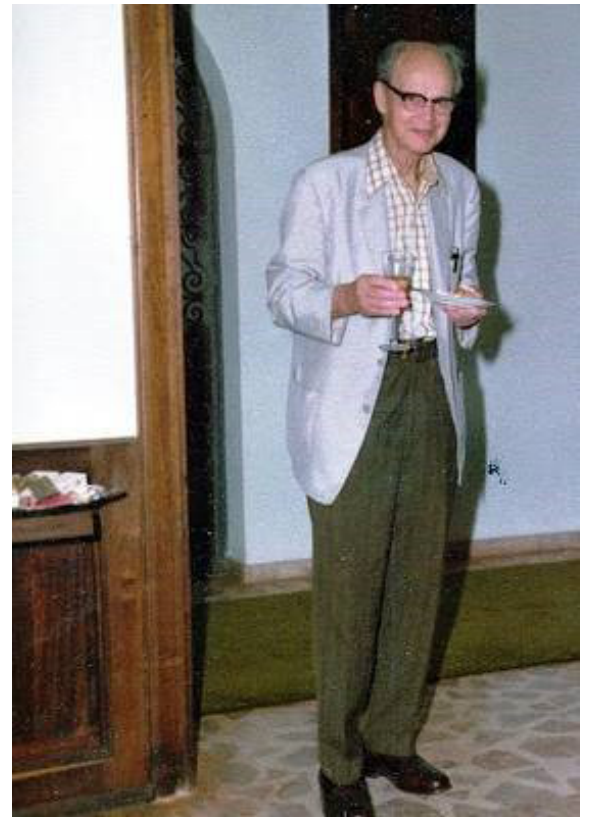
Figure 11. Arthur Casagrande in